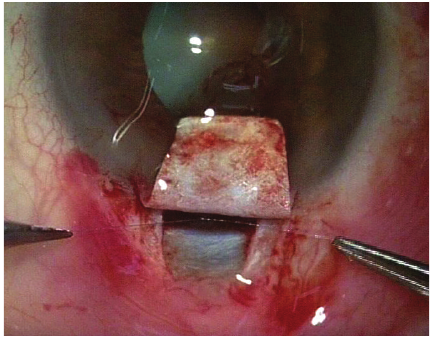
Figure 6: Prolene 10-0